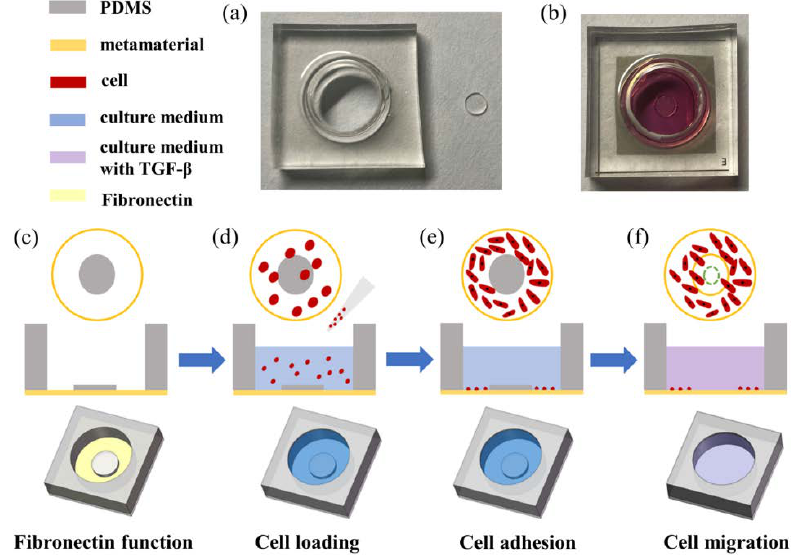
Figure 2. ( a ) Photograph of PDMS chamber and barrier sheet; ( b ) photograph of biosensor after cell loading; ( c – f ) schematic diagram of the process of cell migration experiment; ( c ) fibronectin function; ( d ) cell loading; ( e ) cell adhesion; ( f ) cell migration. The human breast cancer cell lines MDA − MB − 231 transfected with red fluorescent protein gene (MDA − MB − 231 − RFP) were obtained from China Infrastructure of Cell Line Resource. These cell lines were cultured in high-glucose Dulbecco’s Modified Eagle Me- dium (DMEM; HyClone) supplemented with 10% fetal bovine serum (FBS; HyClone), penicillin (100 U/mL, Gibco), and streptomycin (100 µg/mL, Gibco) and maintained at 37 °C in a humidified incubator with 5% CO 2 .